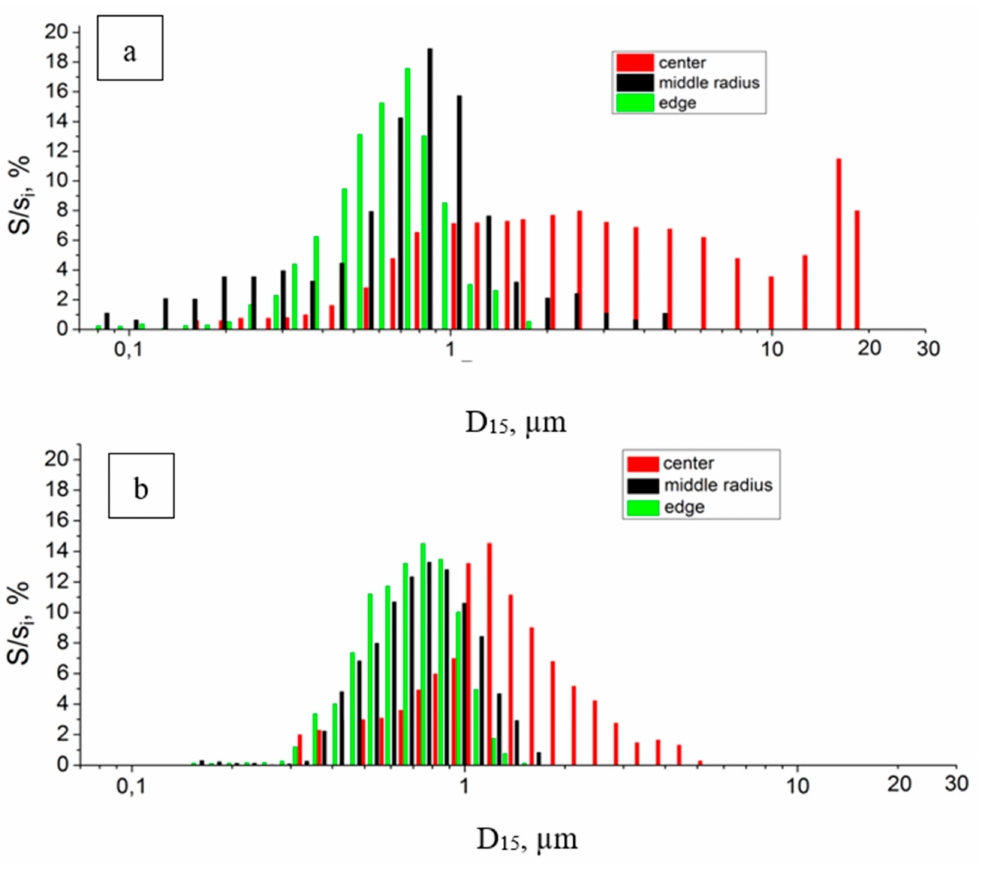
Figure 4. D 15 grain size distribution by the grains specific area (S / S i ) after HPTE in the ( a ) transverse and ( b ) longitude sample sections.